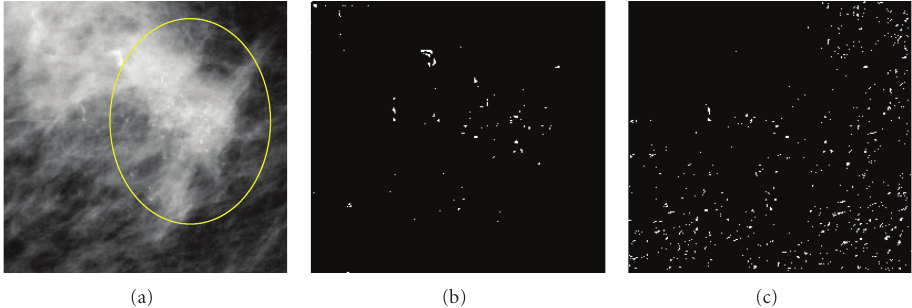
Figure 11: Detection results of MCs in fatty mammogram (mdb209) using di ff erent K : (a) original mammogram (ROI of size 256 × 256 pixels, NMD = 0.16), (b) K = 1, (c) K = 0 . 1 .